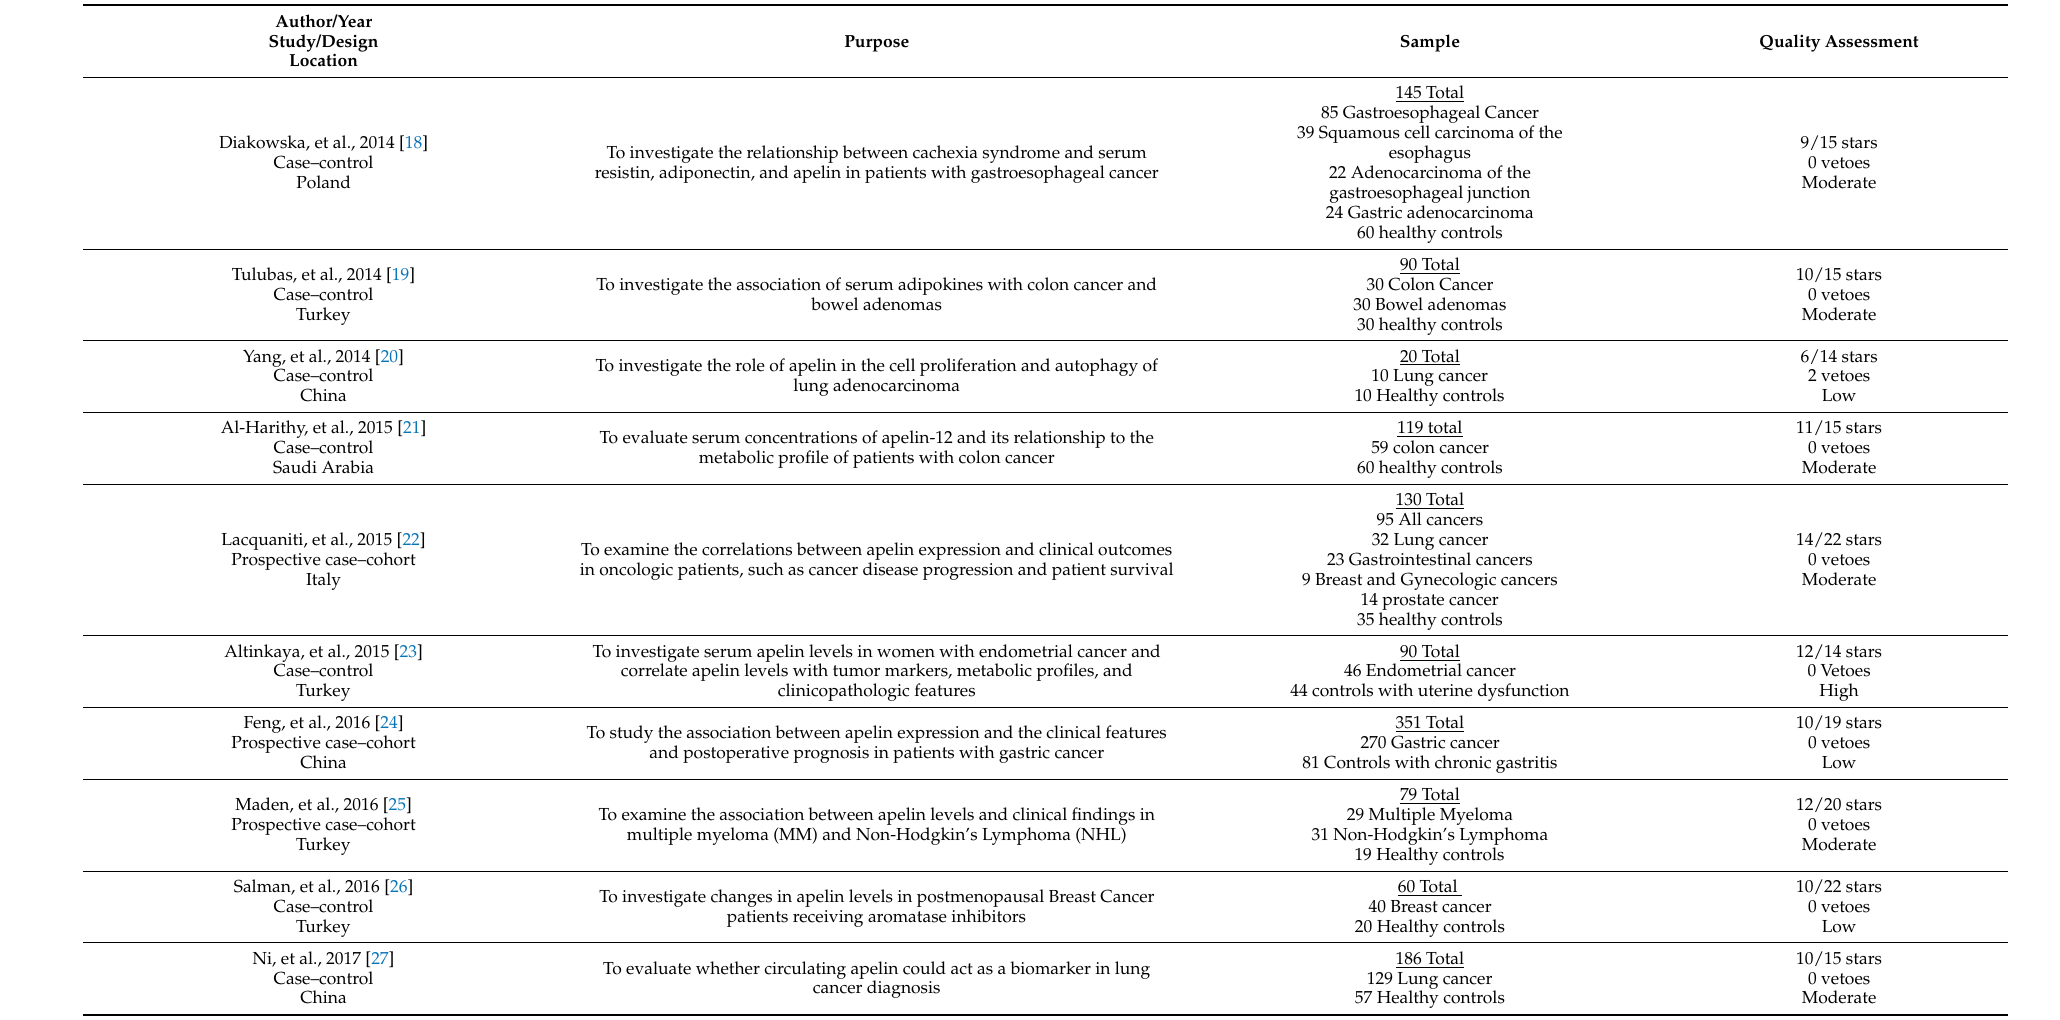
Table 1. Summary Description of Study